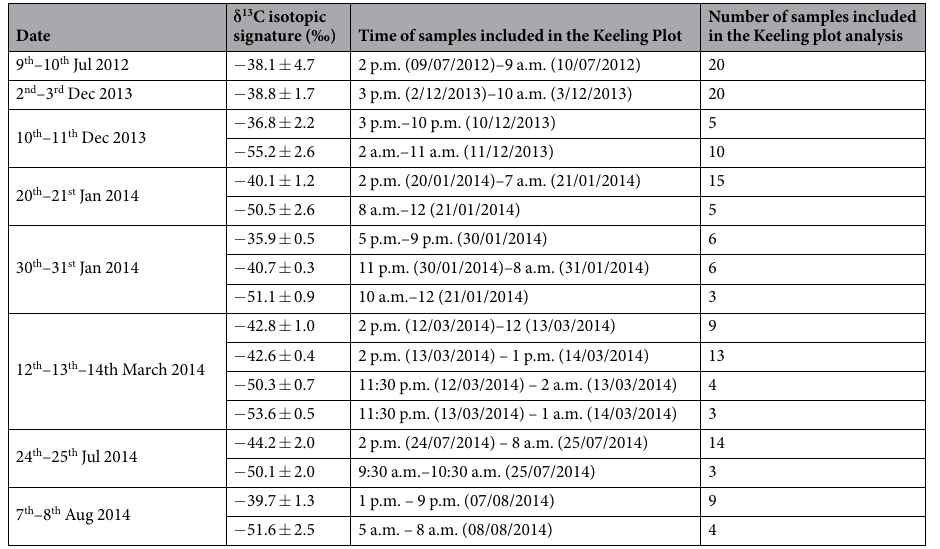
Table 2. δ 13 C source signatures calculated with the Keeling plot analysis for each diurnal study. Time is in UTC. Errors are indicated as 2 standard